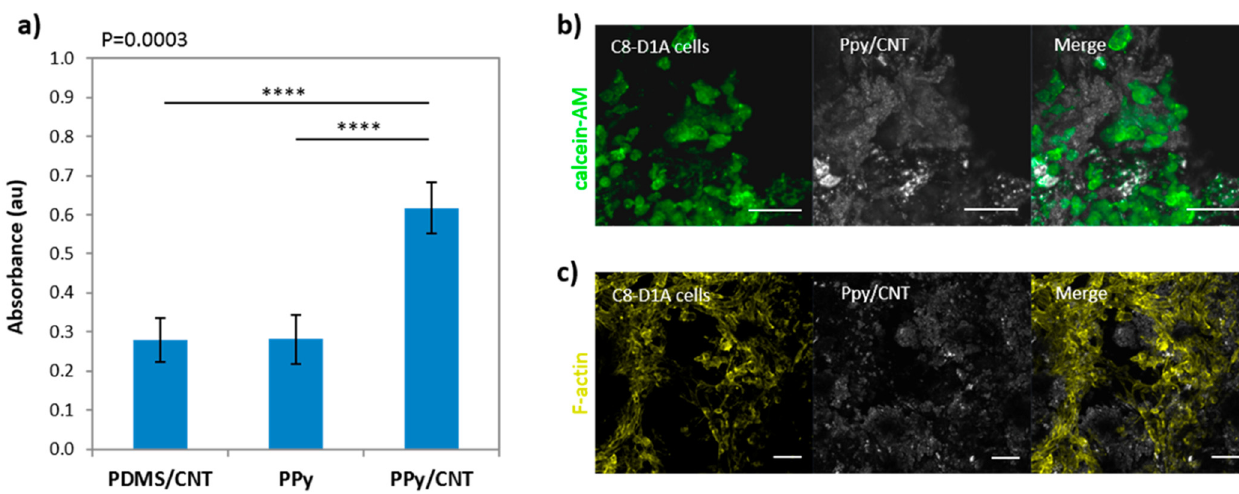
Figure 15. ( a ) In vitro cytotoxicity assay of C8-D1A astrocytes cultivated for 48 h on scaffolds in the presence or absence of CNTs. Absorbance readings for each scaffold are plotted as an average of five independent experiments ( n = 4 ± SD). Confocal images after ( b ) calcein-AM stain of viable cells (green) and ( c ) the F-actin cytoskeleton (yellow) staining of PPy/CNT scaffolds after 2 days of culture. From left to right: stained cells (green or yellow), scaffold (gray), and merge. Images are split views of Z-stacks maximum intensity projections (57 µ m optical sections). The elongated morphology of the cells indicates a good biocompatibility of the material. Scale bar = 50 µ m. Reprinted with permission from reference [199]. Copyright (2018) American Chemical Society.